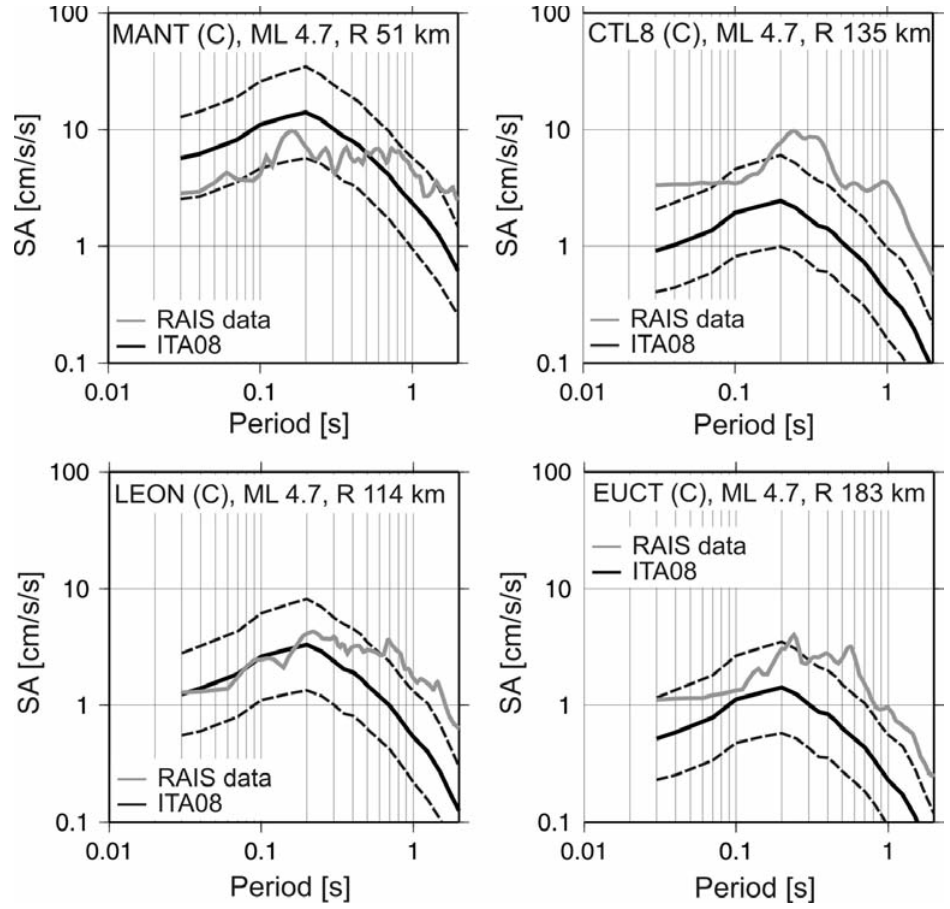
Figure 6. Comparisons between the SA (5% damping) obtained from the recordings of the July 17, 2011, event (gray lines) for the stations located in the central part of the Po Plain and those predicted by Bindi et al. [2010] (ITA08). Solid black lines, dashed black lines, median and ±1 v of the model,